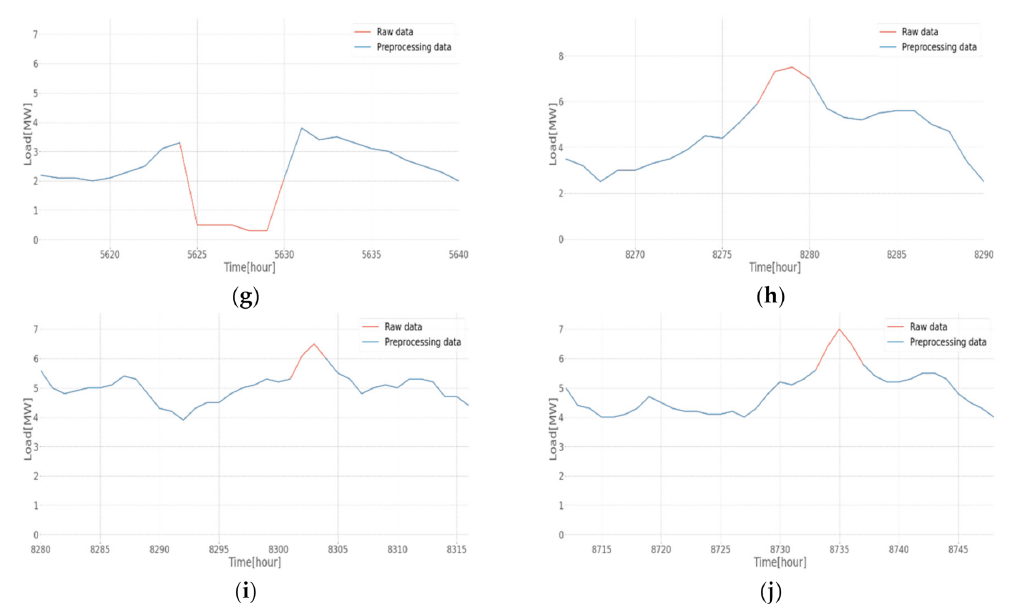
Figure 10. The load transfer detection results in Kimhwa DL using proposed methods: ( a ) the preprocess-